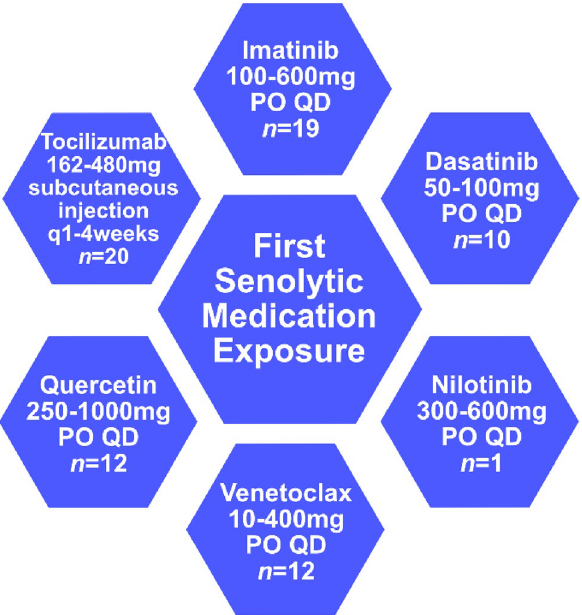
Figure 2. Generic names and dosage ranges of the first senolytic exposure in patients with glaucoma, glaucoma suspect, or ocular hypertension. PO = by mouth, QD = every day.